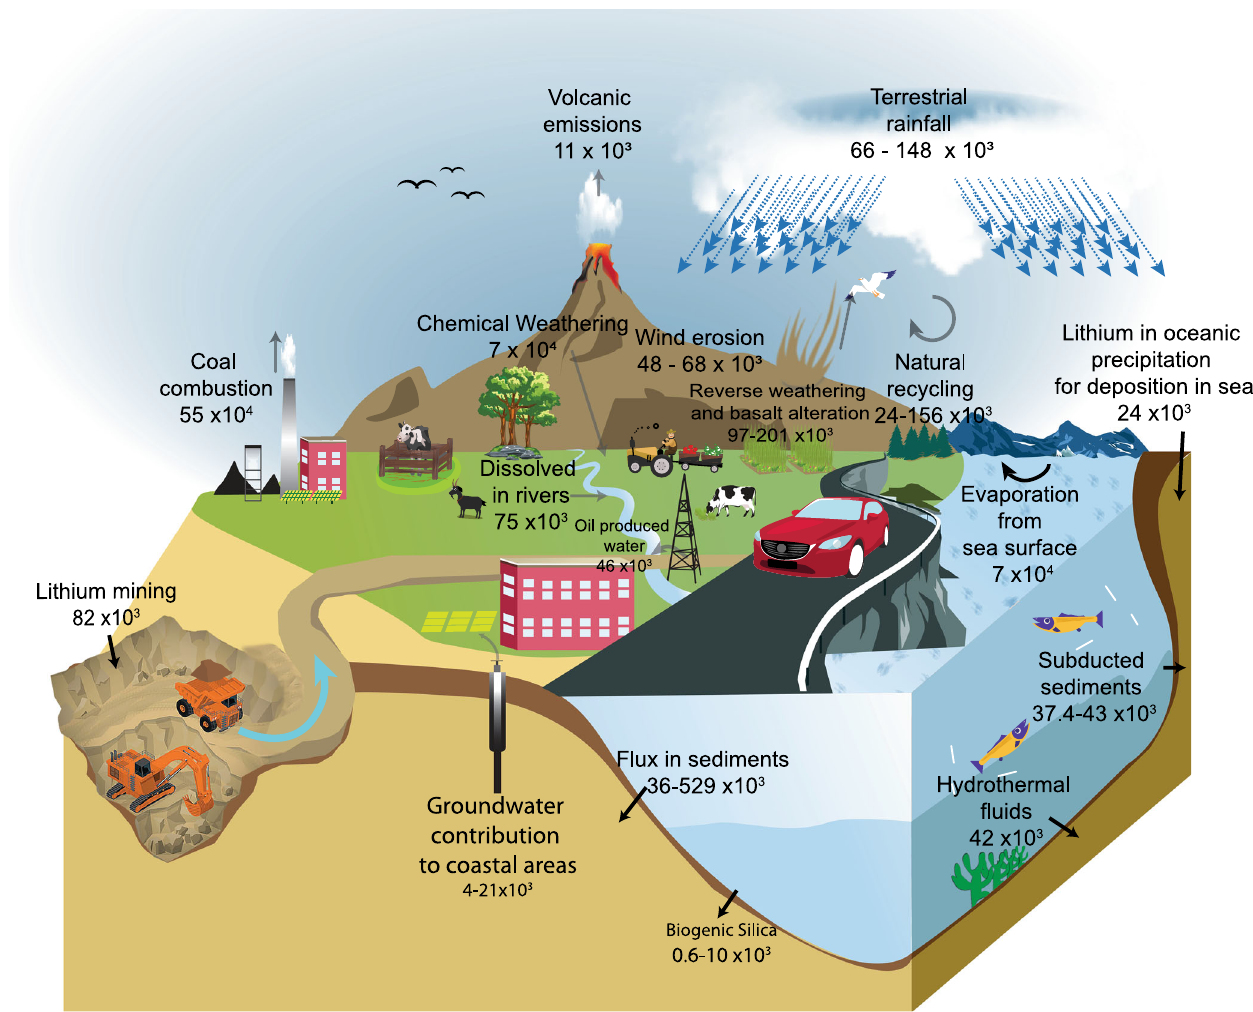
Fig. 1 Li entrance pathways into environmental compartments of the global Li cycle. Each environmental compartment represents a speci fi c annual value of Li fl ux in tons per year. Data presented in the fi gure were extracted from the